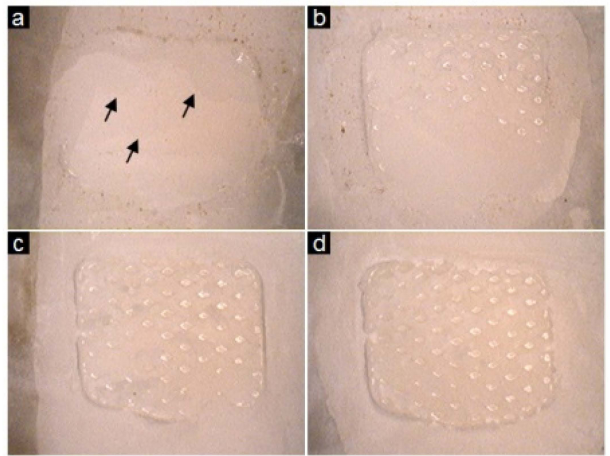
Figure 6. Debonded surfaces after shear bonding test. ( a ) Debonded enamel surface after shear bonding test of Transbond XT. Black arrows indicate cracking of sound enamel; ( b ) Debonded enamel surface after shear bonding test of BAG_0; ( c ) Debonded enamel surface after shear bonding test of 45S5F_A; ( d ) Debonded enamel surface after shear bonding test of